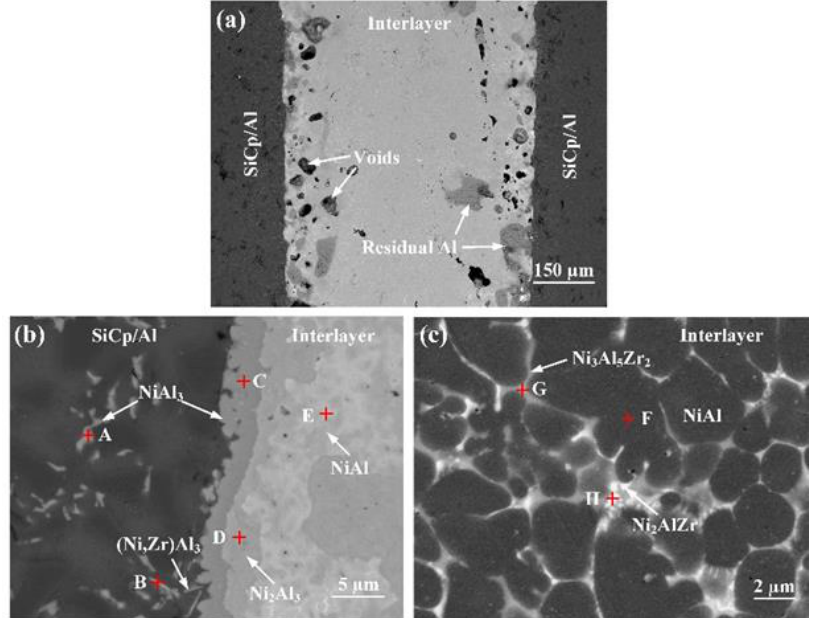
Figure 6. Typical microstructure of the SiCp/Al joint bonded with a Ni – Al – Zr interlayer (Zr 15 wt.%, 3 MPa). ( a ) The overall joint; ( b ) the bonding interface; ( c ) the interlayer products.